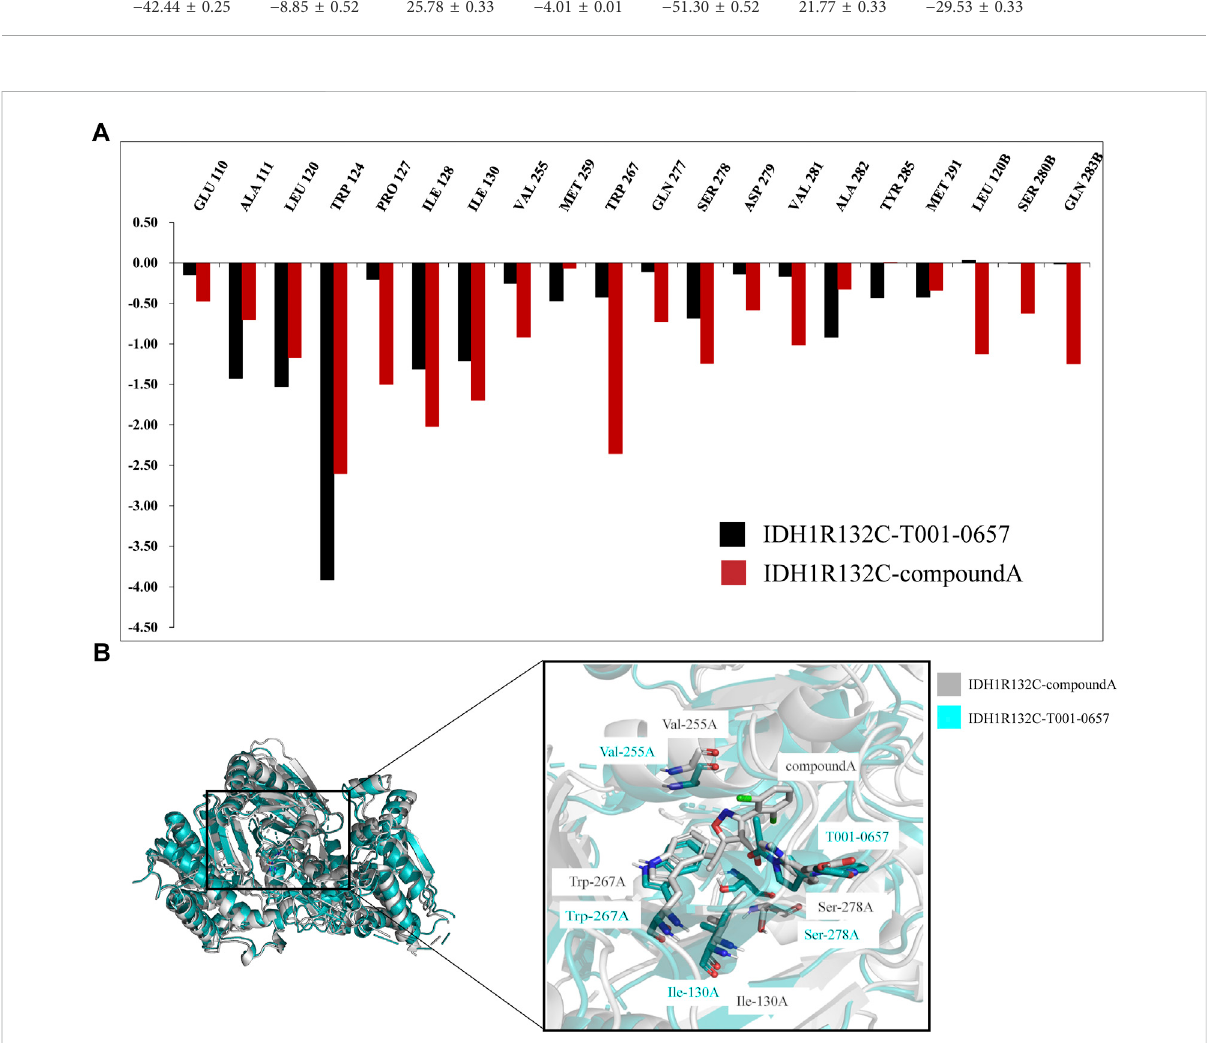
FIGURE 6 Binding free energy and per-residue decomposition studies. (A) A comparison of the speci fi c energy contributions of IDH1 -R132C inhibitors bound to key residues. (B) A comparison of the average conformational overlap maps generated by extracting 1,000 frames of conformation from the two complex